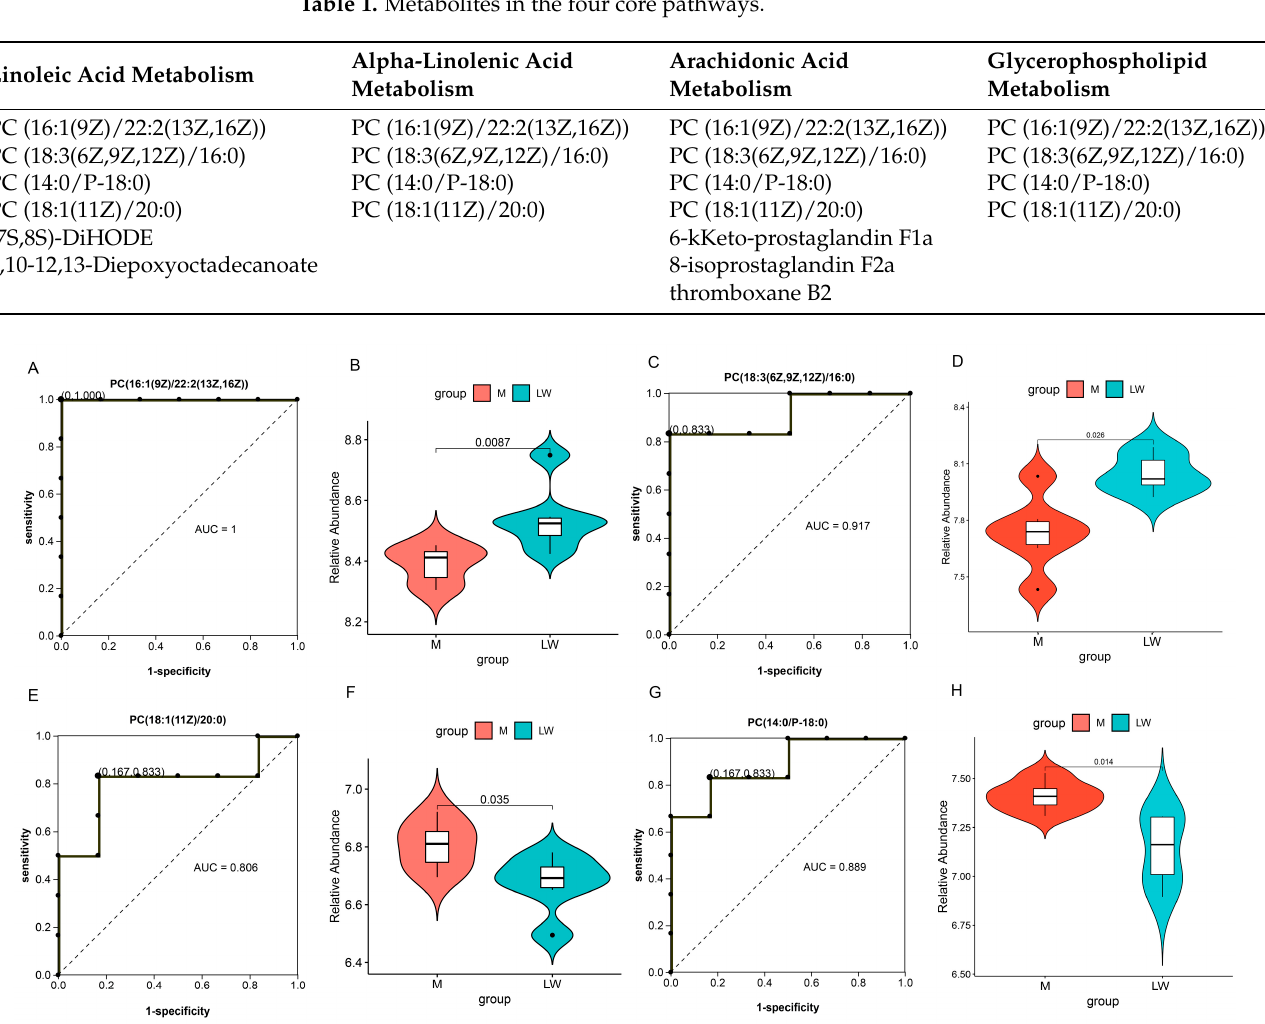
Figure 6. Receiver operating characteristic (ROC) curves and expression abundance of critical metabolites. ( A , C , E , G ) ROC curve for 4 key metabolites and ( B , D , F , H ) expression abundance of four metabolites in the serum of M pigs and LW pigs; red represents M pig, and blue represents LW pig.